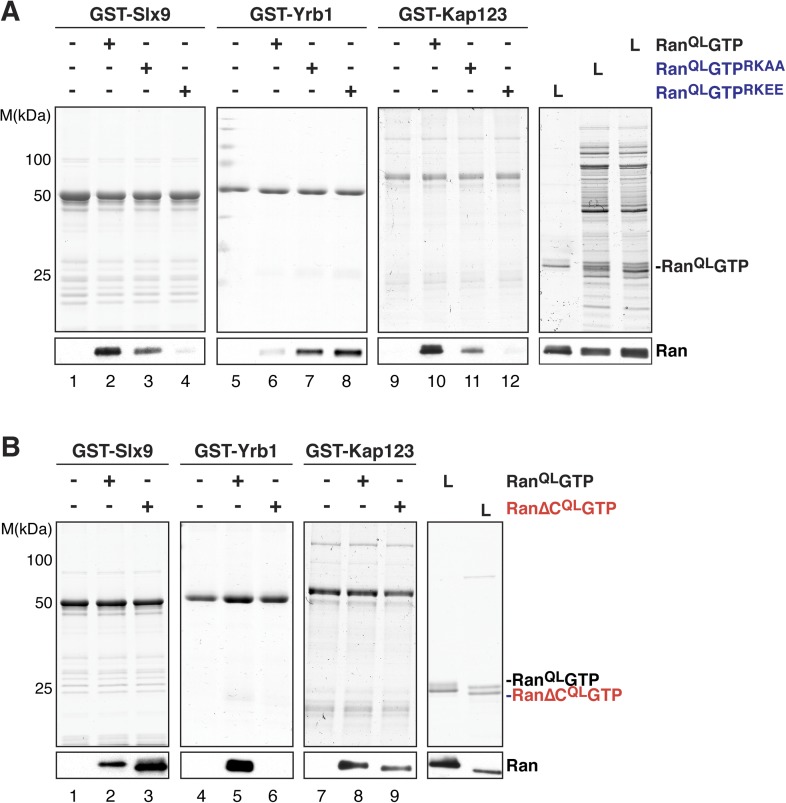
The basic patch and acidic tail of Ran modulates interactions with Slx9.(A) The basic patch of RanQLGTP contributes to Slx9 binding. GST-Slx9, GST-Yrb1, or GST-Kap123 immobilized on GSH-Sepharose was incubated with buffer alone or 2 µM Ran (His6-RanQLGTP, His6-RanQLGTPRKAA, or His6-RanQLGTPRKEE). After washing, bound proteins were eluted in LDS sample buffer, separated by SDS-PAGE and visualized by Coomassie staining or Western blotting using the indicated antibody. L = input. (B) The acidic tail of RanQLGTP negatively regulates interactions with Slx9. GST-Slx9, GST-Yrb1, or GST-Kap123 immobilized on GSH-Sepharose was incubated with buffer alone or 2 µM Ran (His6-RanQLGTP or His6-Ran∆CQLGTP). Analysis of the eluted proteins was carried out as described in (A). L = input.